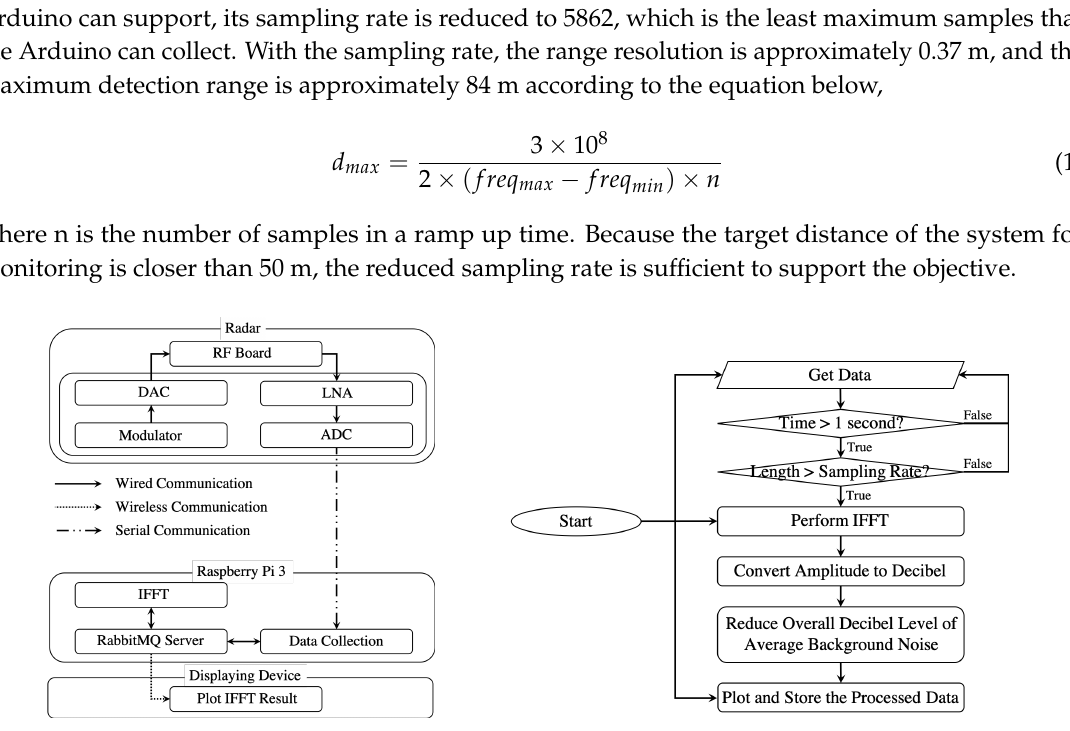
Figure 7. Component diagram for version two radar system ( left ), data processing flow for the version two radar system ( right